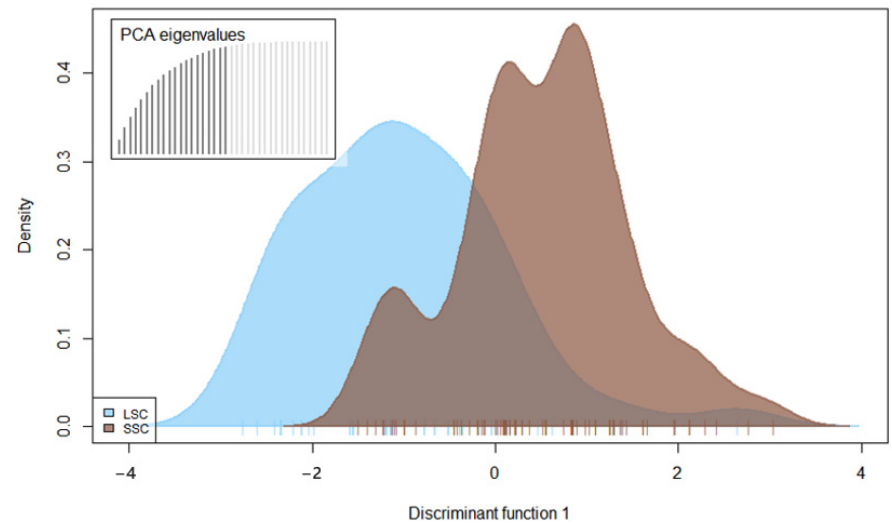
Figure 8. A discriminant analysis of the principal components (DAPC) of P. infestans isolates (non- clone corrected) collected on large-scale conventional farm (LSC) and small-scale farm (SSC). DAPC fails to discriminate between populations. Colors indicate population. The cross-validated number of the PCs used for the discriminant analysis is shown in the bar plots on the top left of the density plot. A total of 20 PCs explained 99.1% of the variation.